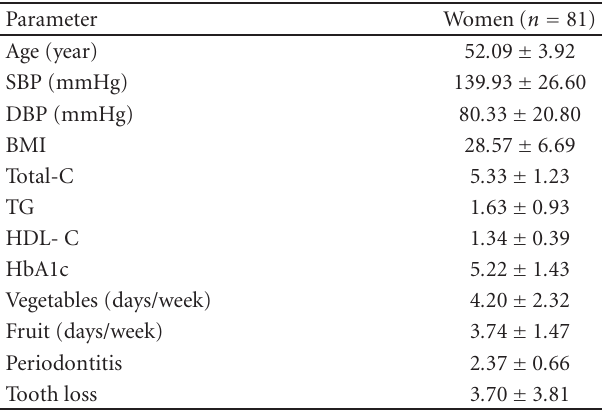
Table 1: Basic characteristics of